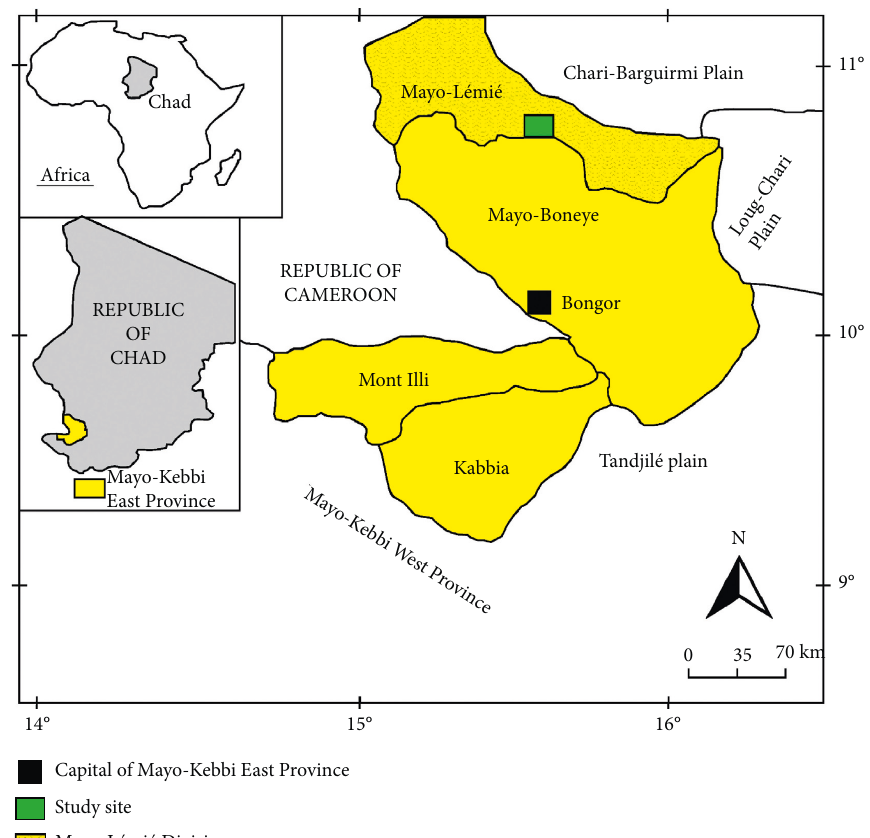
Figure 1: Location of the study